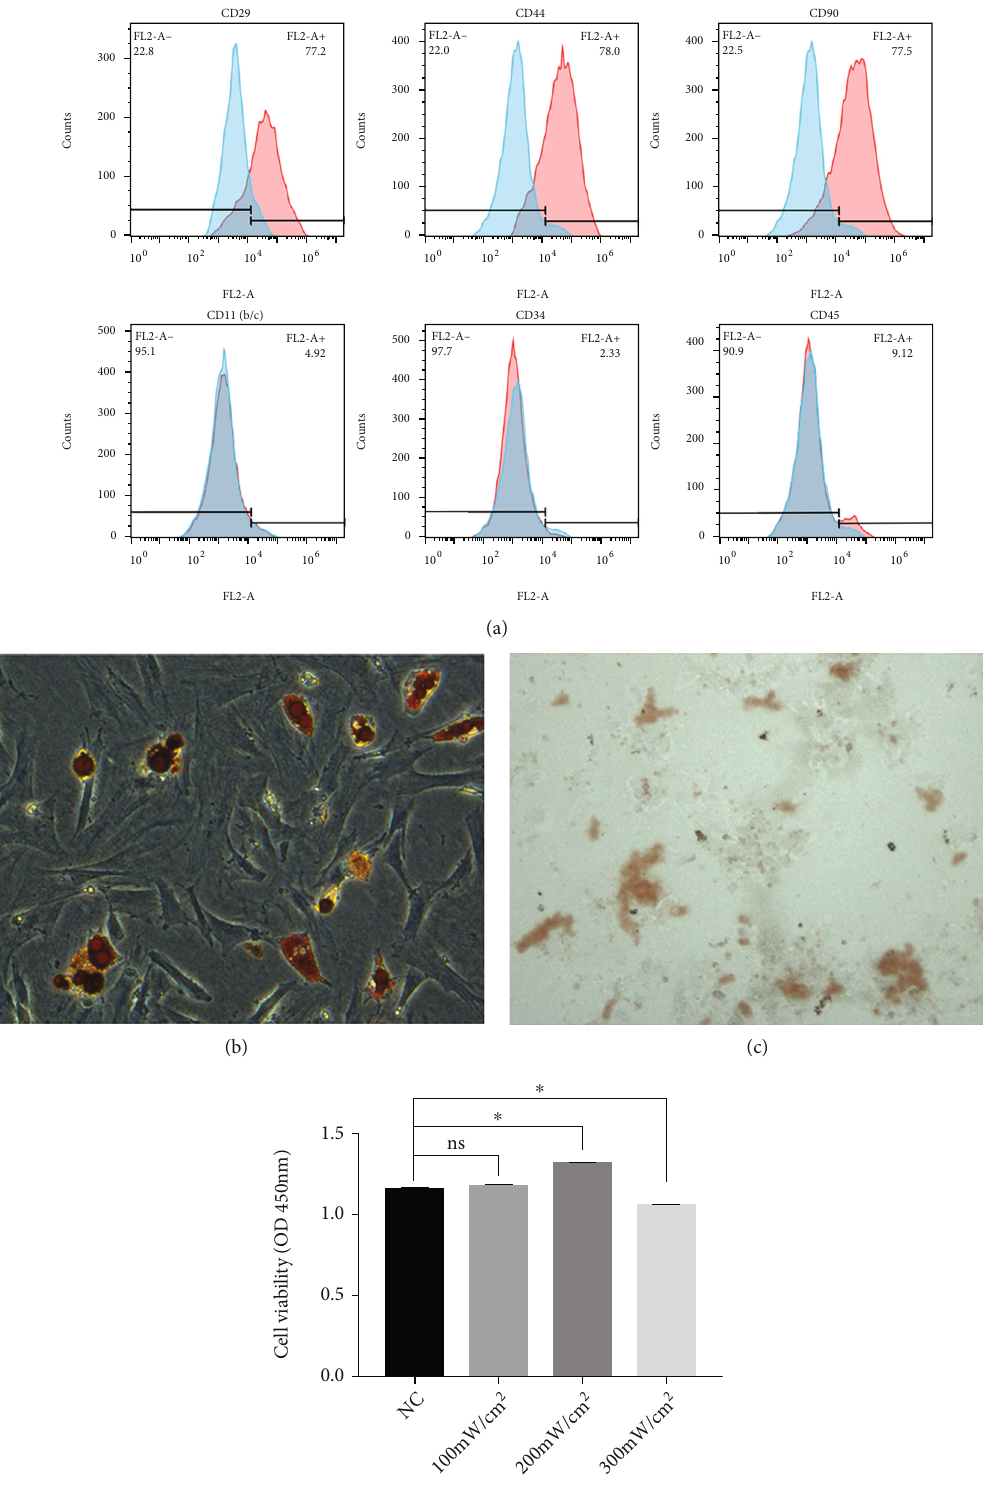
Figure 1: Characterization of ADSCs. (a) ADSCs expressed MSC markers (CD29, CD44, and CD90) but were negative for CD11b/c, CD34, and CD45. (b) After adipogenic induction, the accumulation of lipid droplets in ADSCs was stained with Oil Red O. (c) After osteogenic induction, the accumulation of mineralized nodes in ADSCs was stained with alizarin red S. D The cell viability of ADSCs without or with 100 mW/cm 2 , 200mW/cm 2 , and 300mW/cm 2 intensities of LIPUS treatment. Data are presented as the mean ± standard deviation. ns p > 0 : 05 compared with the NC group. ∗ p < 0 : 05 when comparing the NC